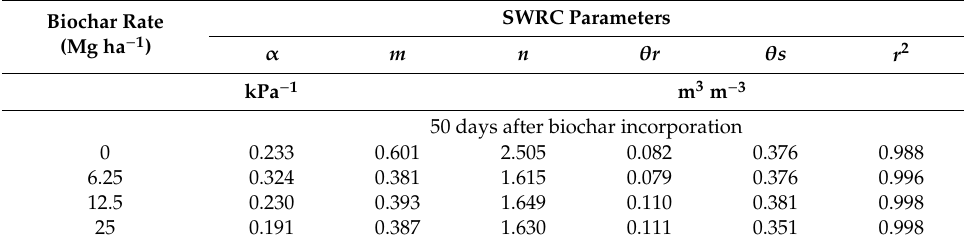
Table 2. Adjustment parameters for the average Soil Water Retention Curves (SWRCs) of a sandy soil amended with di ff erent biochar rates, at two evaluation